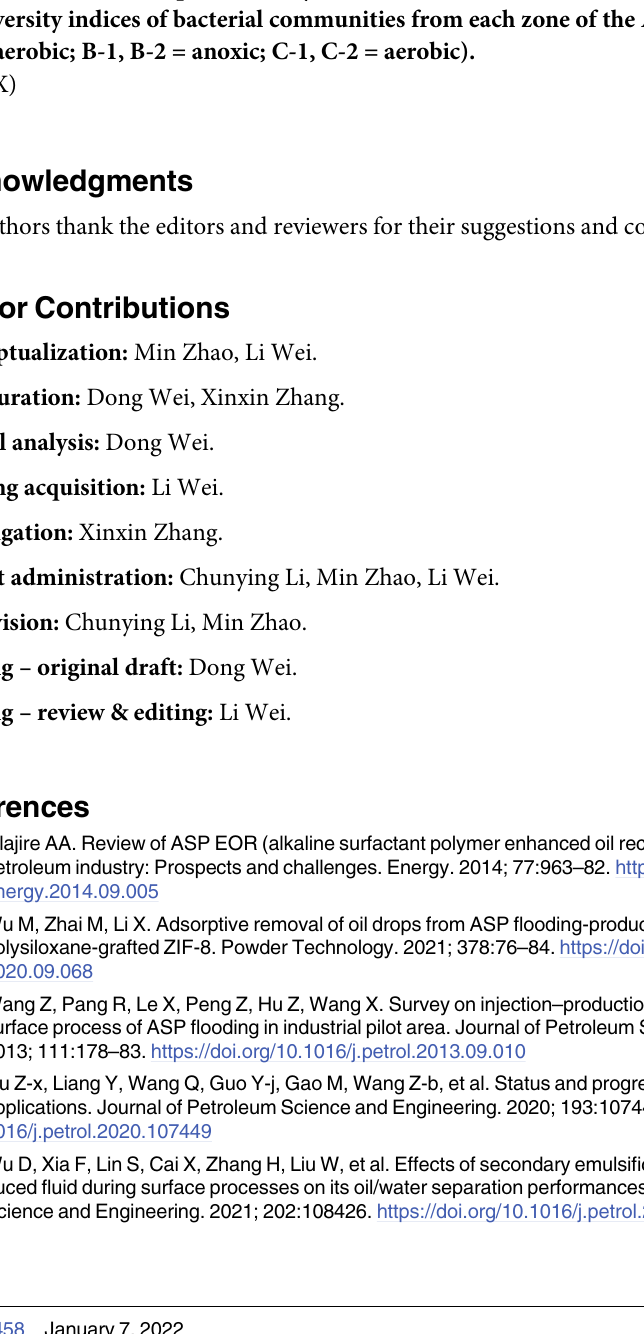
S2 Fig. Dilution curves for samples taken from each zone of the ABR (A-1, A-2, A-3 = anaero- (TIF) S3 Fig. Venn diagram for showing the OTU coincidence for samples from different zones of the ABR: (A) Anaerobic: (B) anoxic (C) aerobic. (TIF) S1 Table. Organic compounds were identified by GC-MS in samples from each region of the ABR. S2 Table. Number of sequences analyzed, OTU richness (Chao, ACE), Shannon and Simp- son diversity indices of bacterial communities from each zone of the ABR (A-1, A-2,